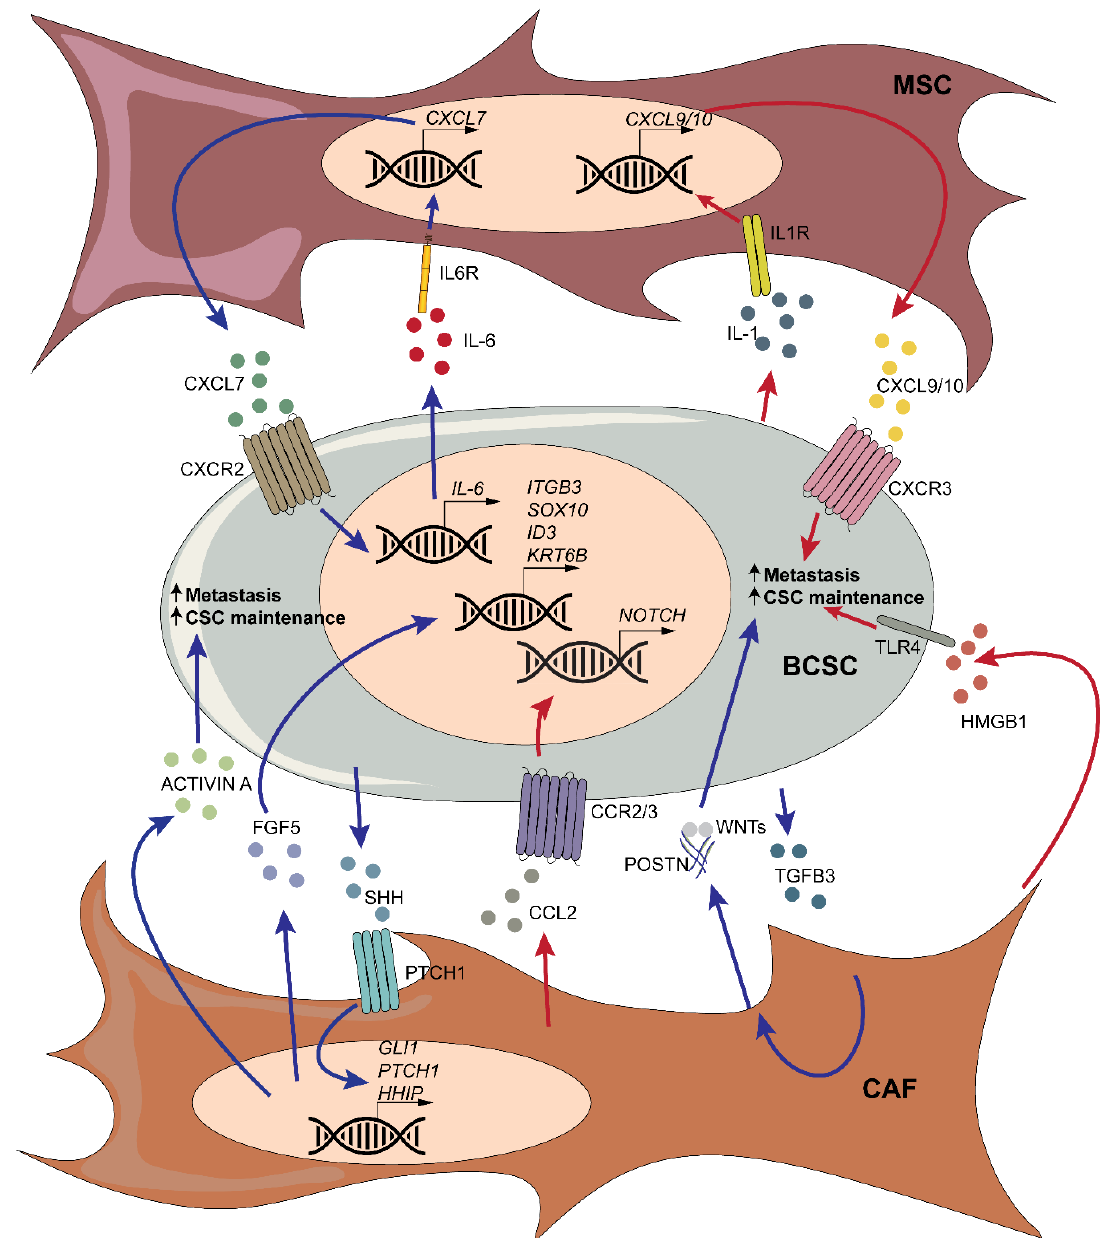
Figure 3. Schematic representation of interactions between mesenchymal stromal cells (MSCs)/cancer- Schematic representation of interactions between mesenchymal stromal cells associated fibroblasts (CAFs) and BCSCs. (MSCs) / cancer-associated fibroblasts (CAFs) and